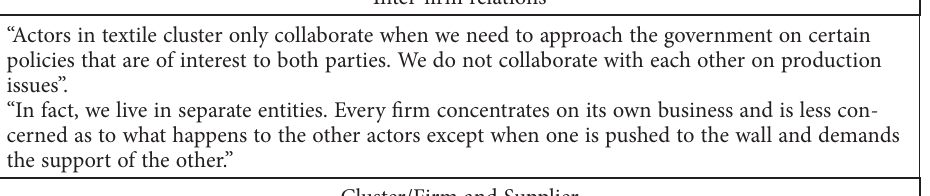
Table 2. Quotations illustrating relations among actors in the textile cluster (source: prepared by au- thors) Inter-firm